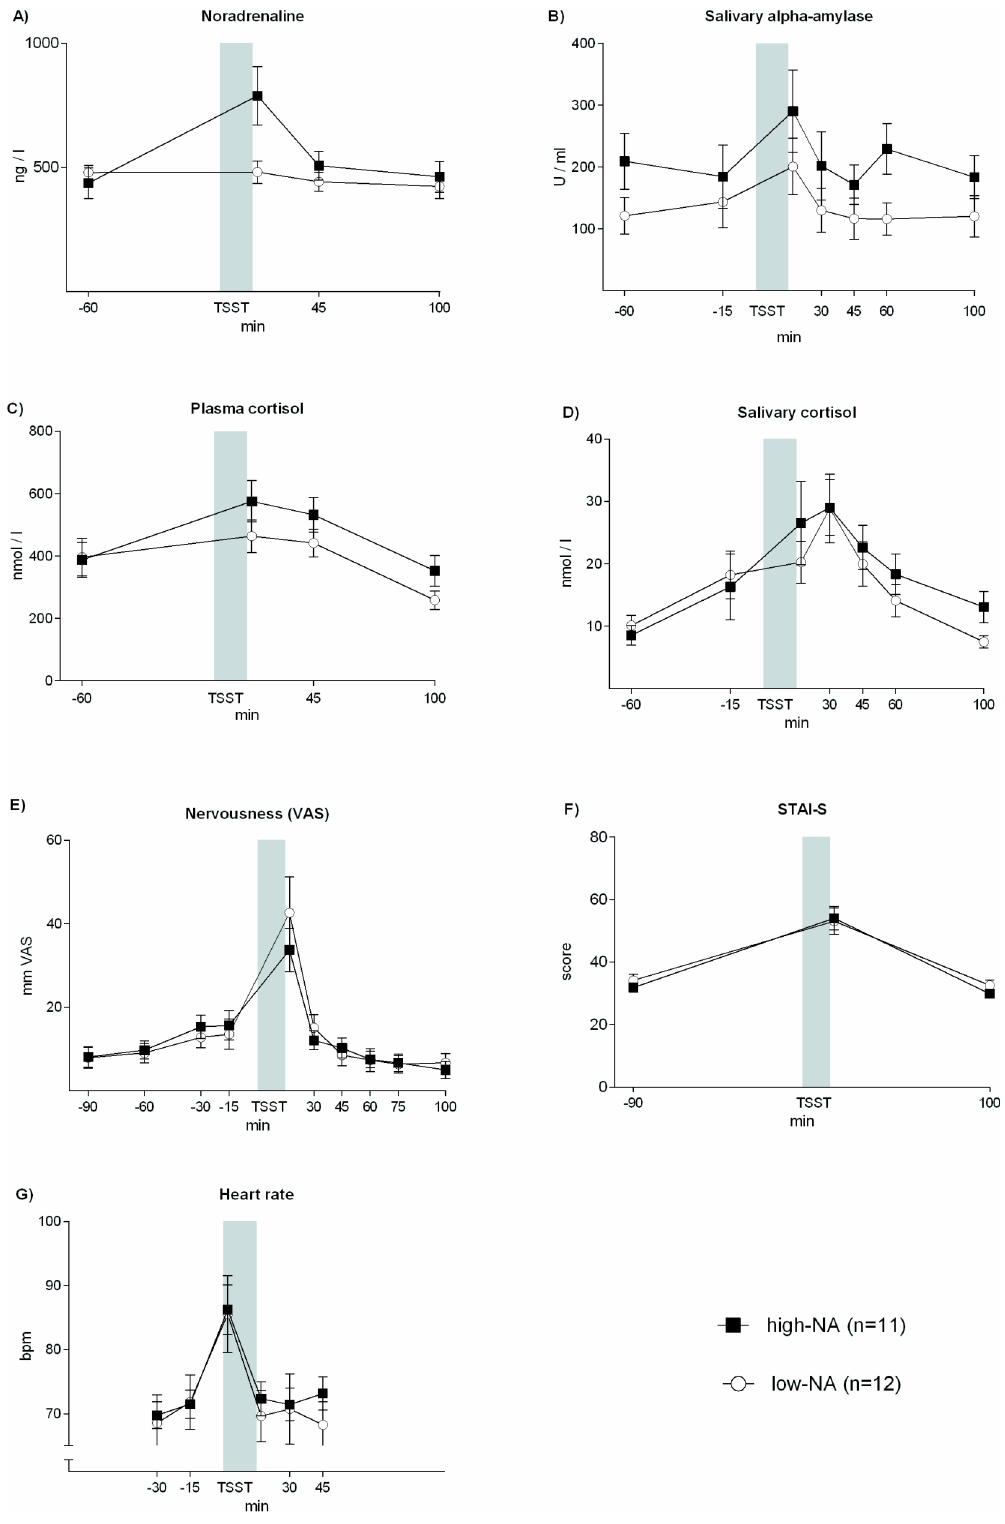
Fig 3. Noradrenaline (A), Salivary alpha-amylase (B), Plasma cortisol (C), Salivary cortisol (D), Nervousness (E), State anxiety (F) and Heart rate (G) in response to the Trier Social Stress Test for 2 groups with high-NA and low-NA response. Results are presented as mean ± SEM.